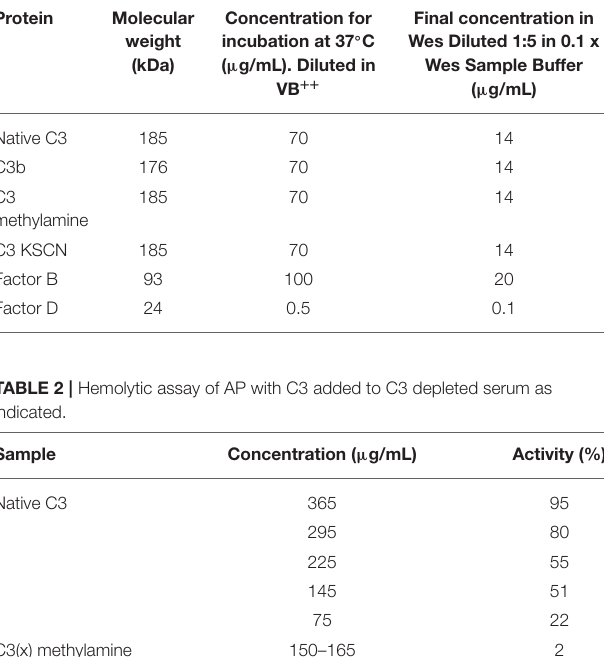
TABLE 1 | The molecular weight, and final concentration of complement proteins used in Wes immunoassay for analysis of C3 convertase formation. Protein Molecular weight (kDa)